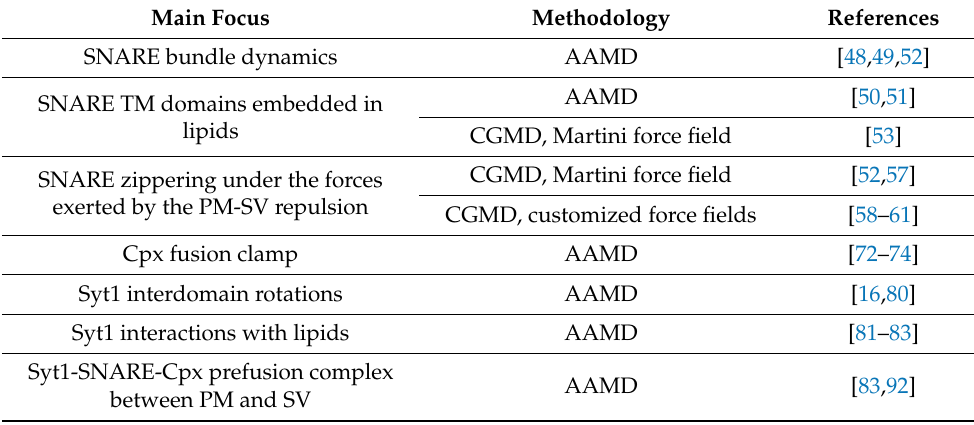
Table 1. A summary of the major MD studies of the synaptic fusion